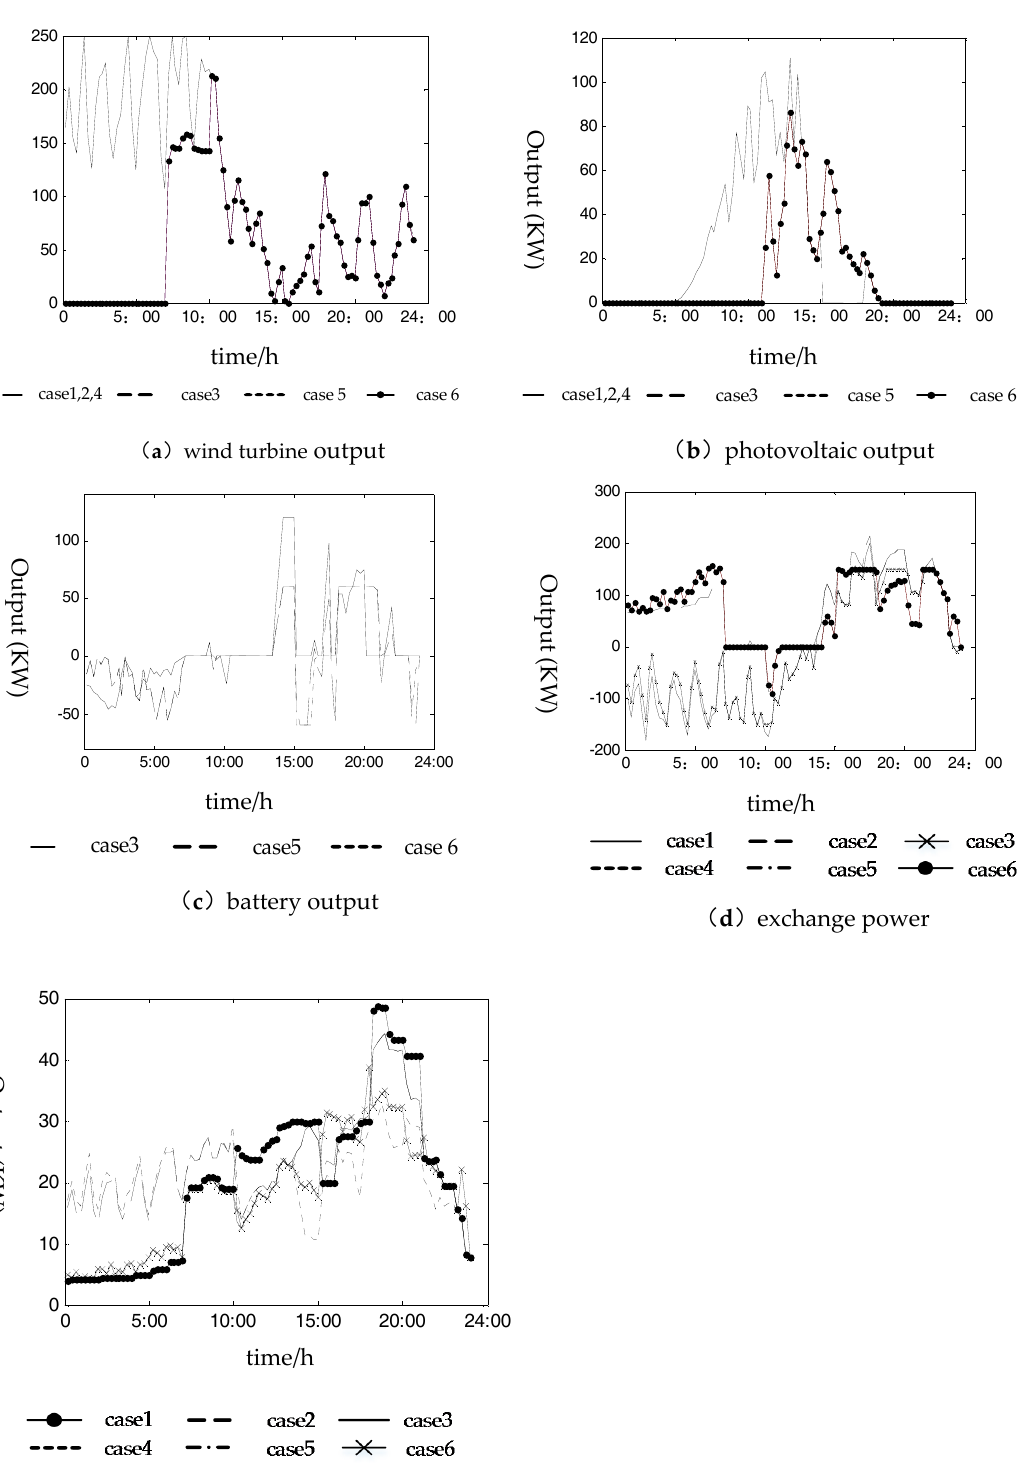
Figure 6. Result comparison of cases 1–6.